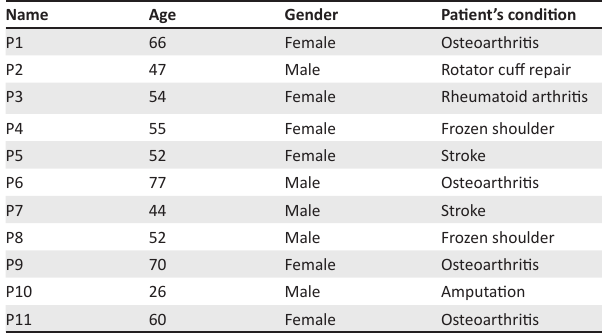
TABLE 1: Patients’